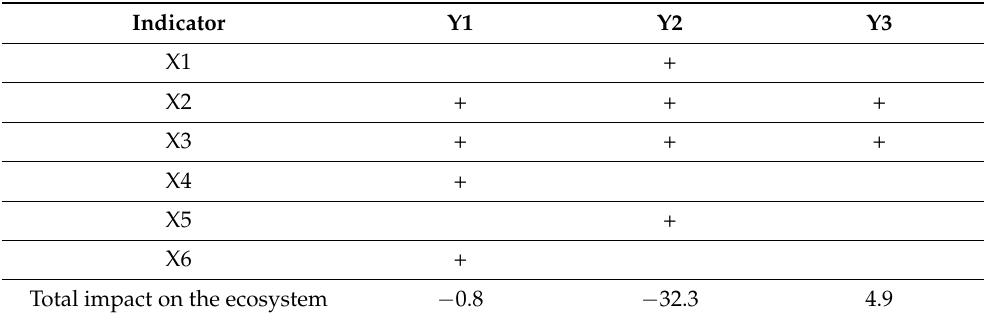
Table 6. Crosstab of dependent and independent variables of regression models describing the ecosystems of the Russian financial sector. Indicator